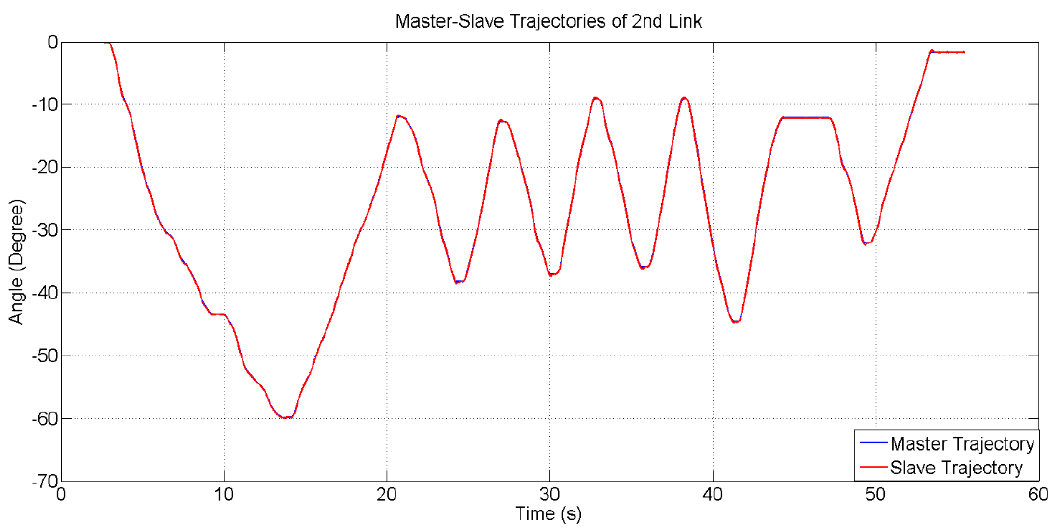
Figure 16. Master–slave trajectories for 2nd link.